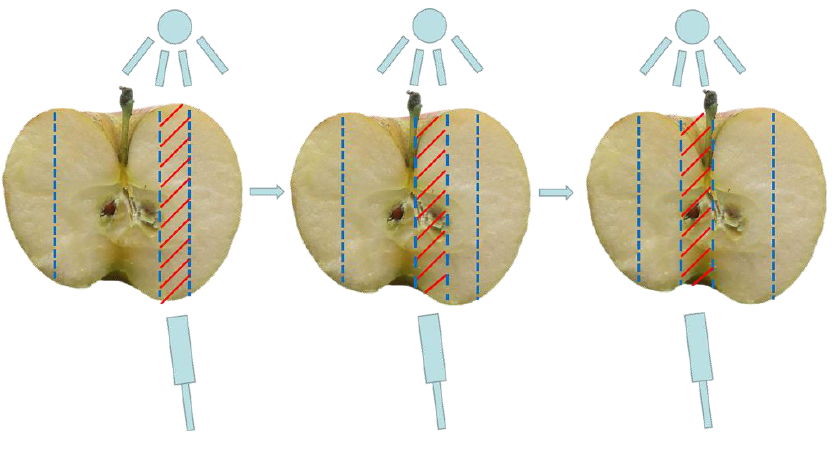
Figure 7. Motion detection diagram.